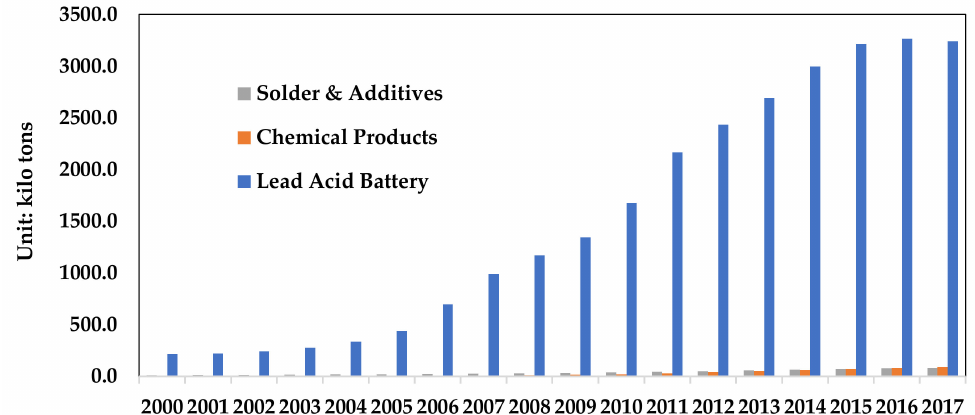
Figure 7. The amount of discarded lead products in China from 2000 to 2017.